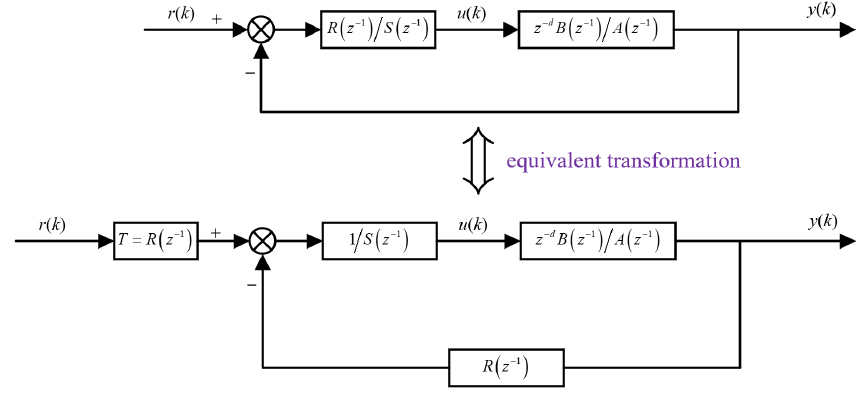
Figure 5. Block diagrams two forms of PID algorithm.